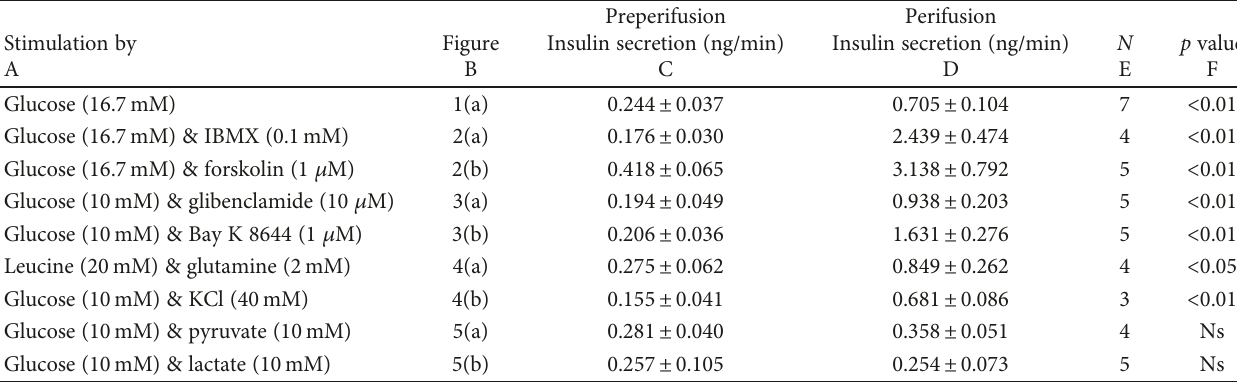
Table 1: Quantitative evaluation and statistical analysis of the insulin secretion rates from perifused EndoC- β H1 pseudoislets in response to stimulation with di ff erent